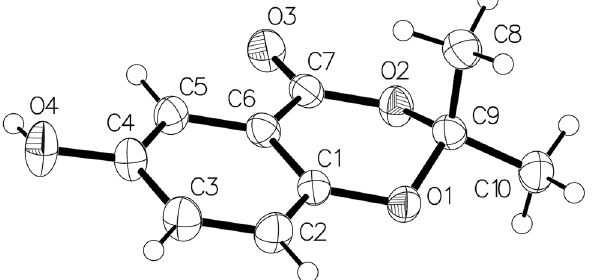
Table  : Data collection and